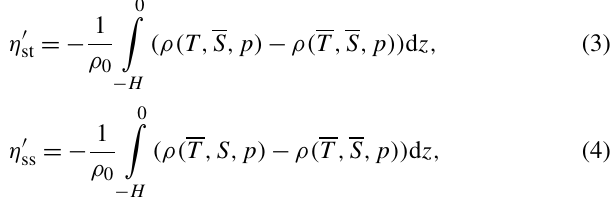
Figure 1. A map of the pan-Arctic Ocean presenting the locations of moorings deployed by the Nansen and Amundsen Basin Obser- vational System (NABOS, black stars labeled M 1 , M 2 , M 3 , M 5 , and M 9 ), by the Beaufort Gyre Exploration Project (BGEP, black stars marked as M a , M b , M c , M d ), and by the North Pole Environ- mental Observatory (NPEO, black star labeled M npeo ). The dashed black lines enclose the Arctic regions used in the following sec- tions. Bathymetry contours of 500, 1000, 2000, 3000, and 4000m are drawn with gray lines. Main rivers are labeled with their names near the river